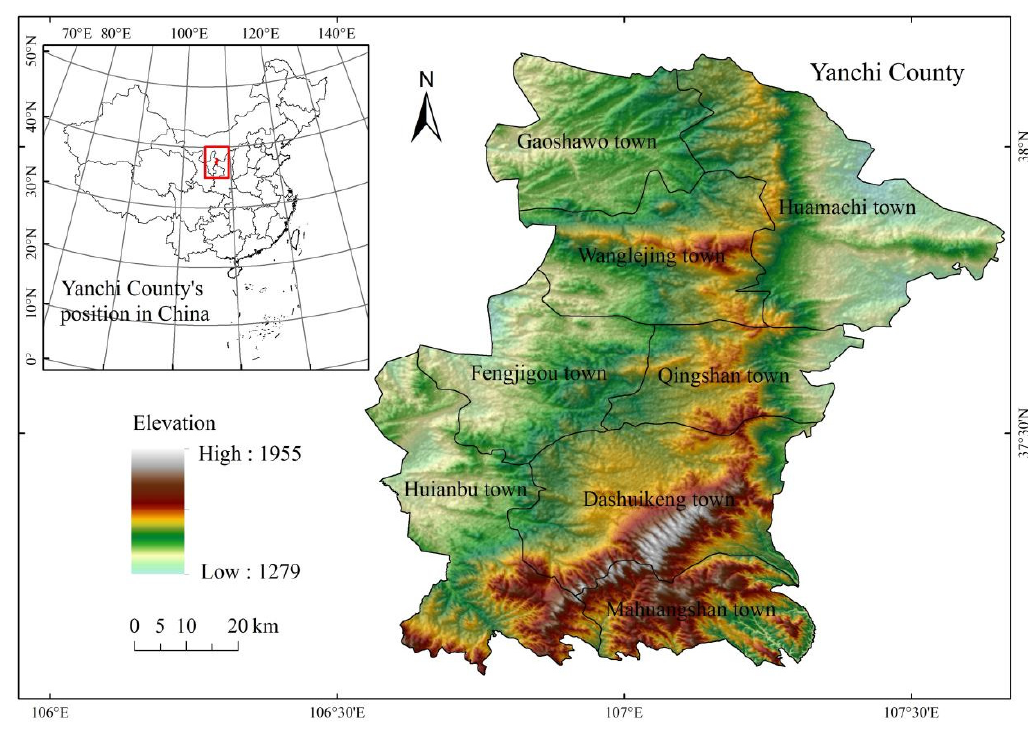
Figure 1. The study area.